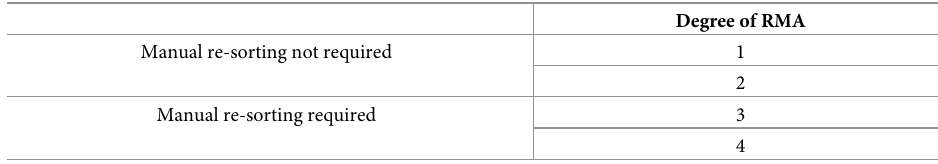
Table 1. Scoring of the amount of RMA of